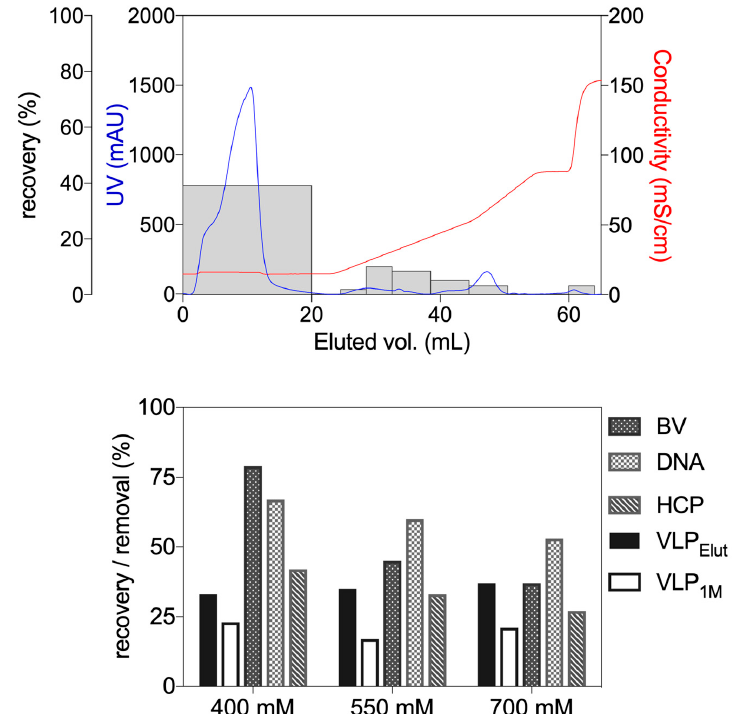
Figure 2. Bind and elute chromatography. Top—gradient elution profile obtained after loading a Fractogel ® TMAE anion exchange 1 mL column with 10 mL of hepatitis C feedstock, recovered after concentration and buffer exchange. Loading was carried at a linear velocity of 200 cm h − 1 . Columns correspond to VLP recovery of each pool recovered. Elution performed using linear gradients from 0–25% and 25–50% of elution buffer, followed by a column stripping step gradient at 100% of elution buffer (2 M NaCl). Bottom—step elution at 400, 550 and 700 mM of NaCl (VLP recovery—black columns) followed by a column stripping step at 1 M of NaCl (VLP recovery—empty columns; n = 1). Removal of baculovirus (BV), DNA and host-cell protein (HCP) was also reported for each elution